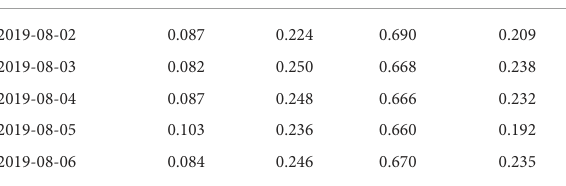
TABLE 1 Twitter dataset: The aggregated (compound) sentiment scores computed with